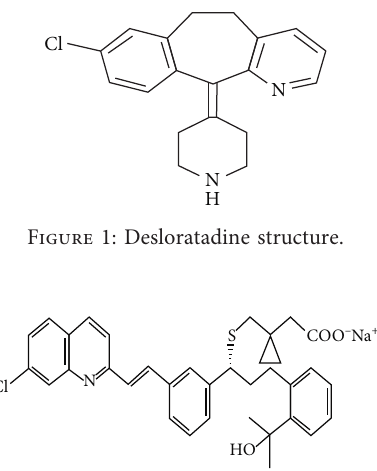
Figure 2: Montelukast sodium